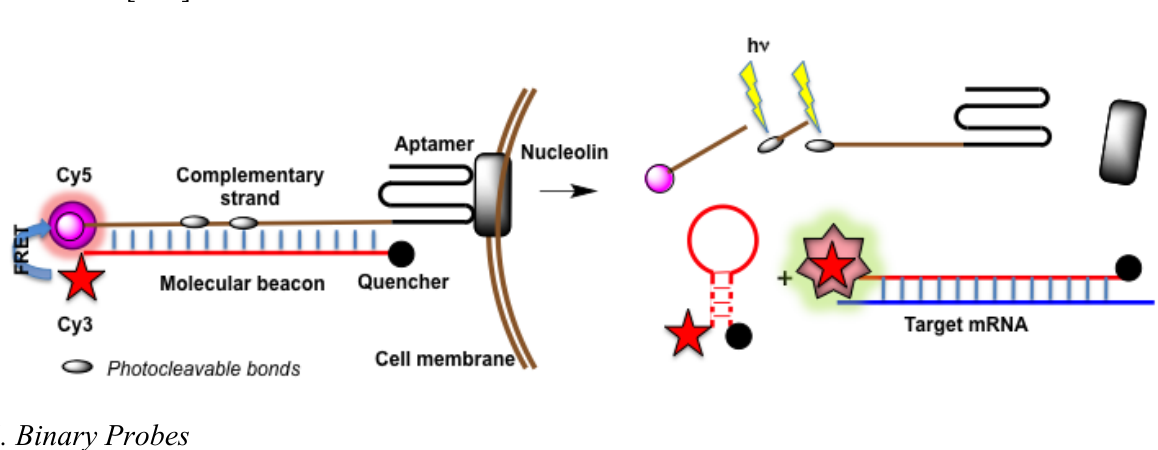
Figure 15. A targeted, self-delivered and photocontrolled aptamer-based molecular beacon